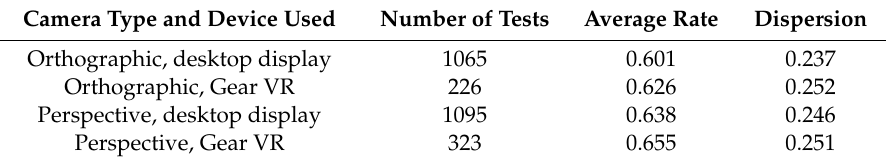
Table A11. Numerical results of the users regarding the camera type and device used.